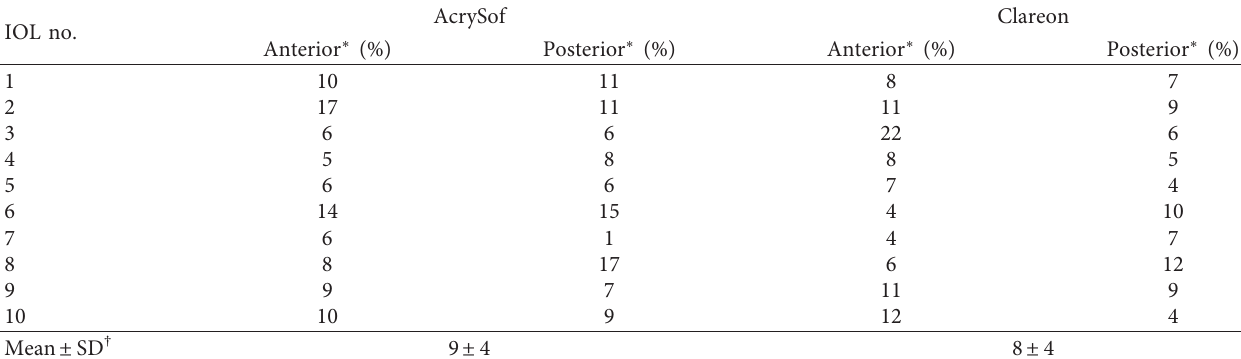
Figure 3: Evaluation with ImageJ for silicone oil adhesion. (a) The whole area of the central optic is given by 450586 pixel 2 . (b) The silicone oil adhesion on the IOL is given by (1) 30492pixel 2 ; (2) 5090pixel 2 ; (3) 5284pixel 2 . The result is the difference between the area wetted with silicone oil and the total area of the optic. Table 1: Percentage of silicone oil coverage on the intraocular lens